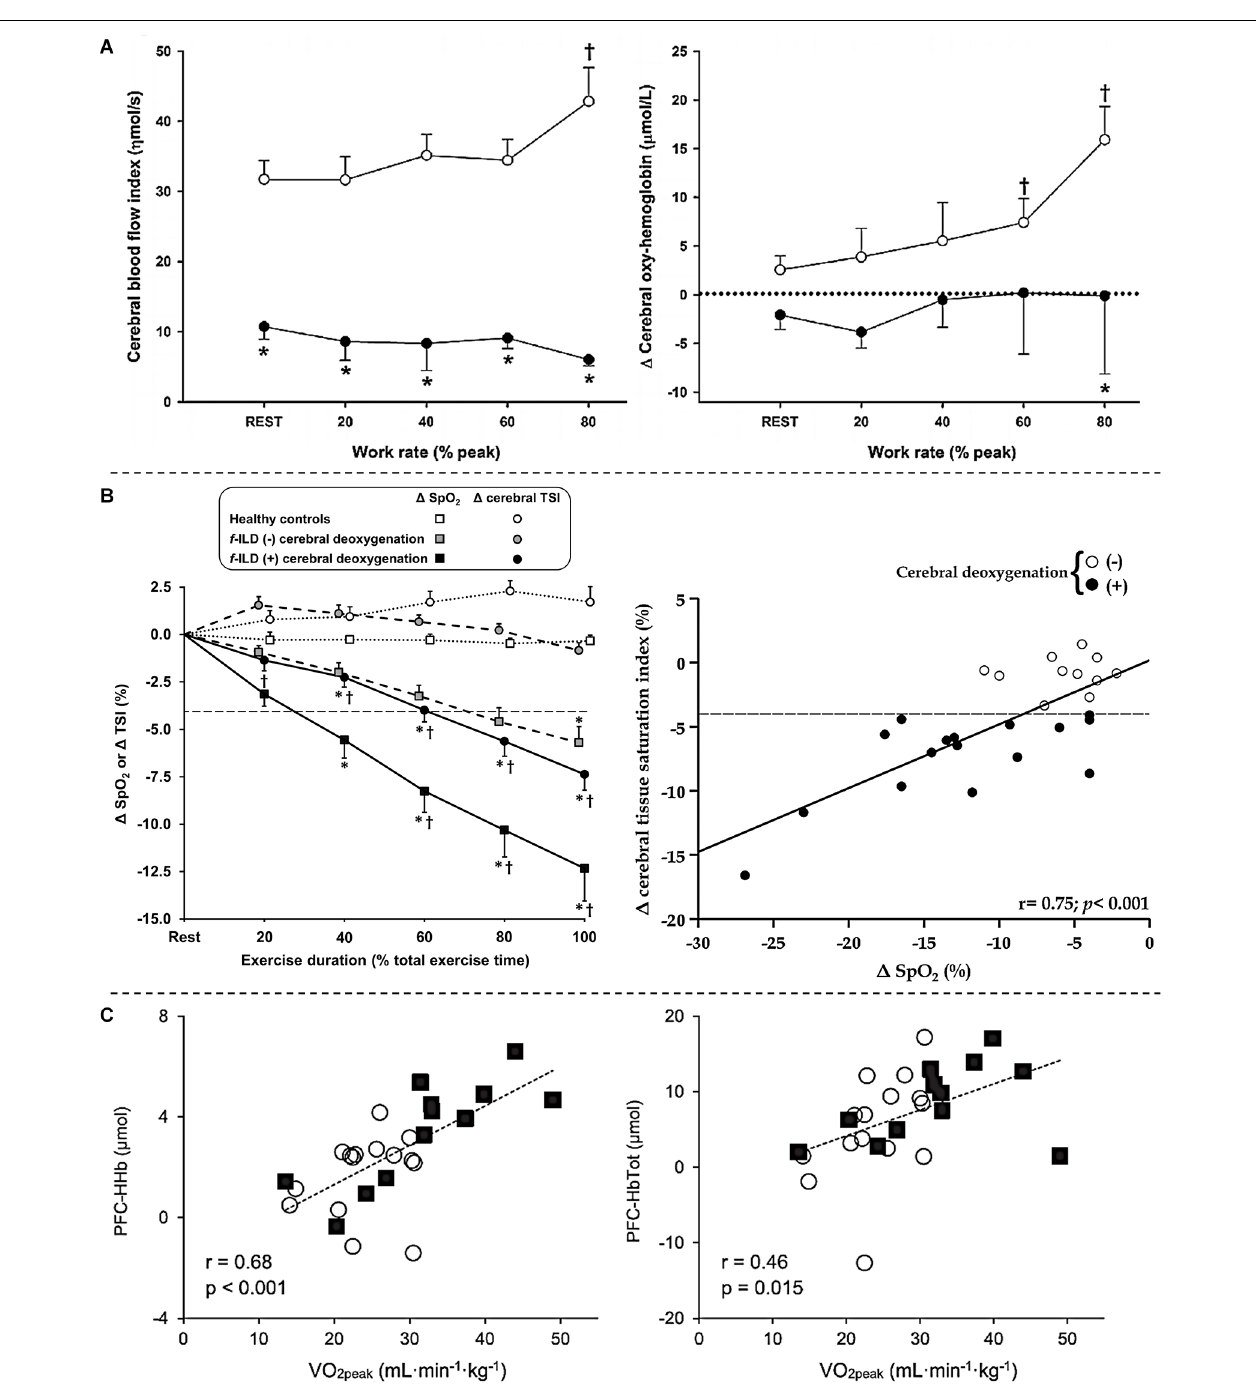
FIGURE 4 | Cerebral hemodynamics assessed by near-infrared spectroscopy in patients with chronic obstructive pulmonary disease-heart failure overlap (panel A ), fibrotic interstitial lung disease (panel B ) and severe obstructive sleep apnea (panel C ) during whole-body exercise. (A) Lower mean arterial pressure and cardiac output together with low levels of arterial partial pressure of CO 2 in patients with overlapping diseases led to poorer prefrontal cerebral blood flow ( left ) and oxygenation ( right ) in comparison to isolated chronic obstructive pulmonary disease during a 4-stage (4 min each at 20% to 80% of peak work rate with 4 min rest in between) cycle ergometer test. Open and closed symbols depict patients with isolated chronic obstructive pulmonary disease and overlapping diseases, respectively. *Between-group differences at a given time point; † intra-group differences vs. rest. Reproduced and modified, with the permission of the publisher from: Oliveira et al. (2016). (B) Profound exertional hypoxemia, a key feature of interstitial lung disease, led to poorer cerebral oxygenation compared to healthy controls ( left ) and impairs cerebral oxygenation in a dose-dependent fashion in these patients ( right ) during incremental exercise testing on a bicycle